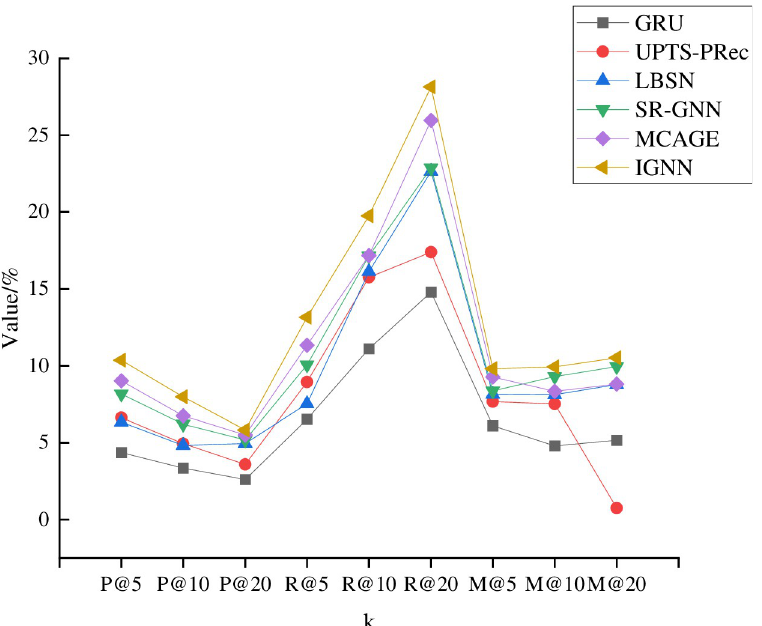
Fig 6. Model training results on Book-Crossings dataset.